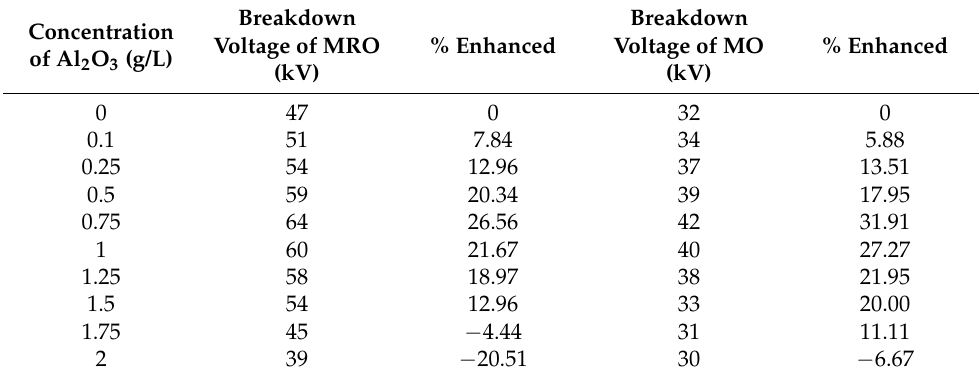
Table 2. Enhancement of Host Fluids using Al 2 O 3